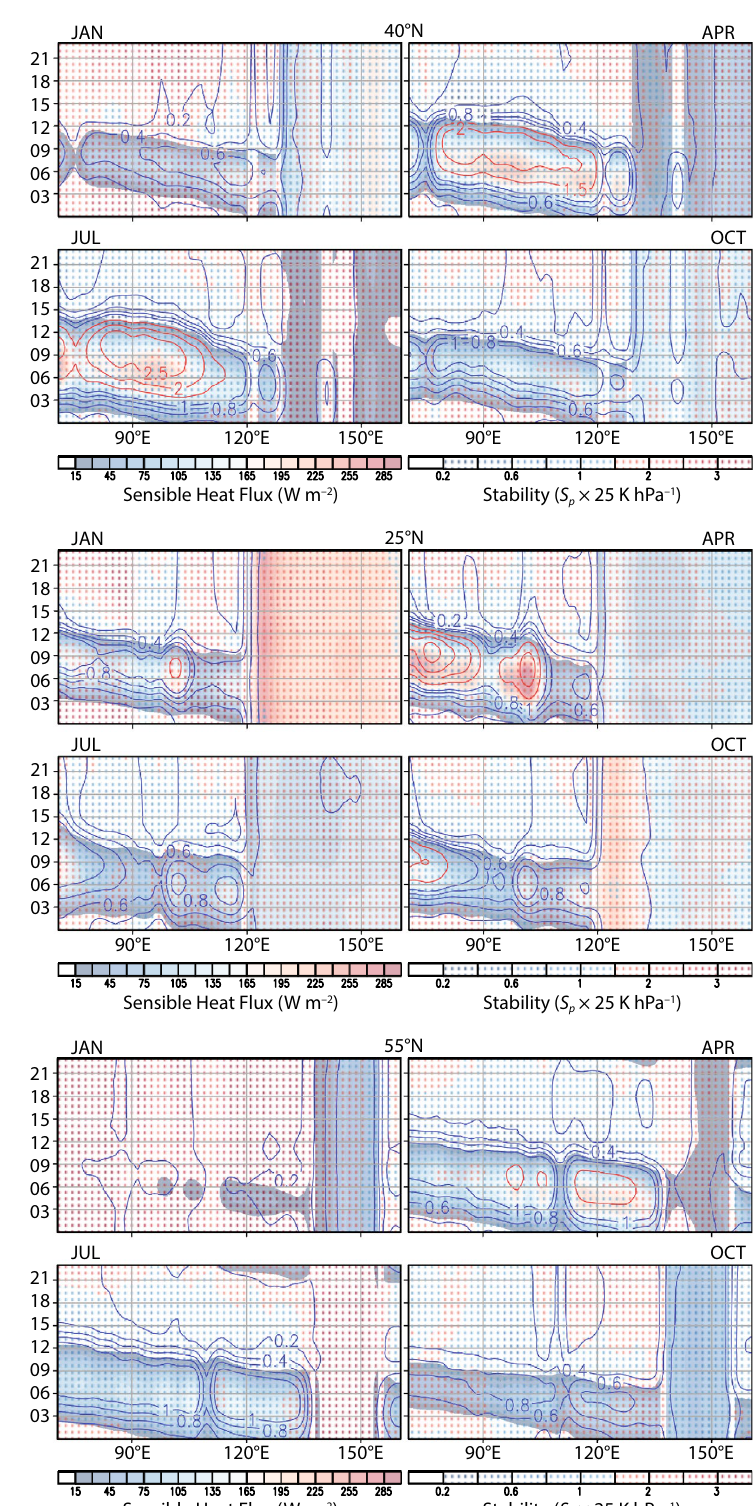
Fig. 6 The diurnal structure of boundary layer height (contours; 0.2 km interval up to 1.0 km and 0.5 km interval thereafter) together with sensible heat flux (shade; W m −2 ) over the continent, latent heat flux (shade; W m −2 ) over the ocean, and stability at the top of the boundary layer (color dots; S p × 25 K hPa −1 ) for the first CSEOF mode (diurnal/ seasonal cycle). The upper color bar represents the shad- ing levels for heat flux and the lower color bar the dot color levels for stability: a 40°N, b 25°N, and c